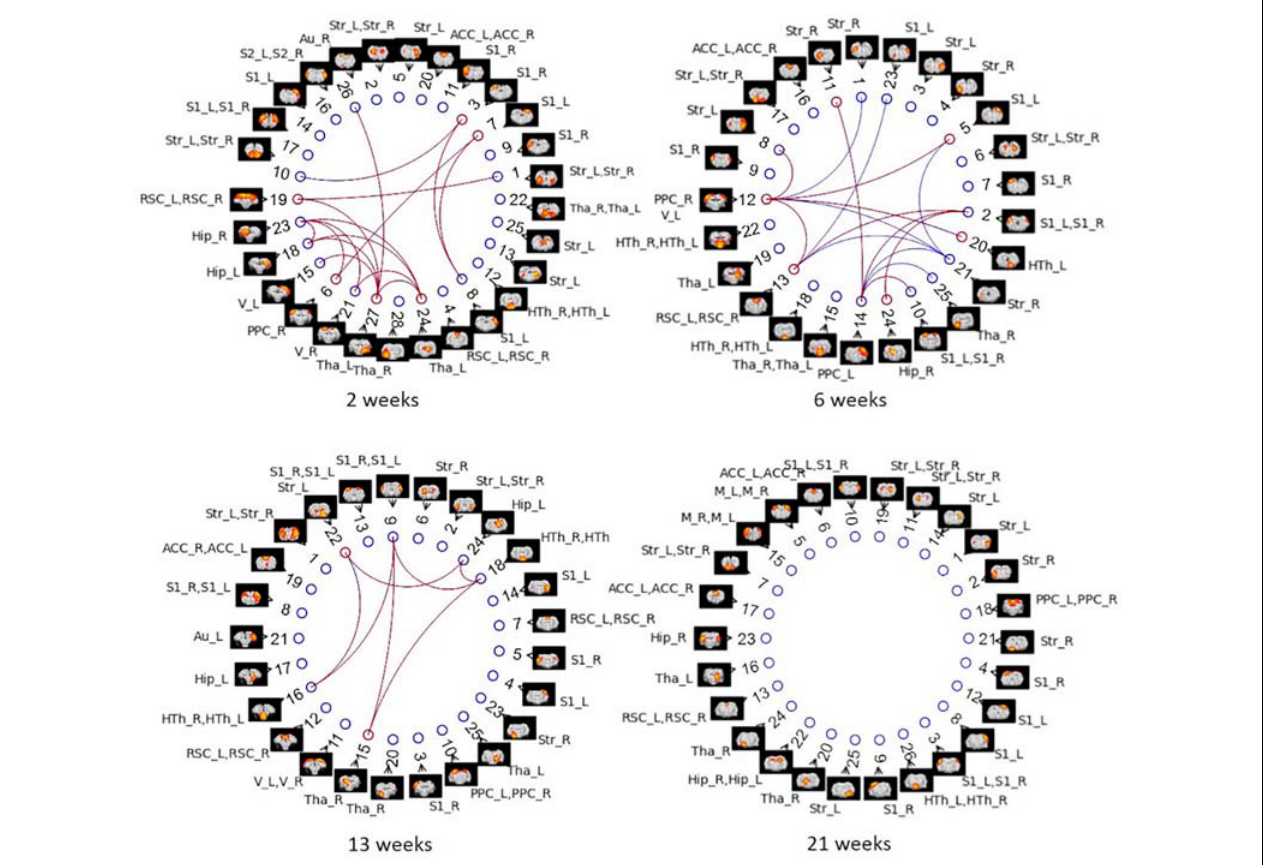
FIGURE 10 | Between-group differences in ICA-based functional connectivity with GSR (partial correlation) at NBS threshold of 2.2 for each timepoint in Cohort 1. Colored edges display the existence of STZ–CTL difference in connections between ICs. Each IC is denoted by a spatial map and its IC number. The nodes of ICs are listed in an order based on its position in the brain (anterior to posterior). ROI labels are attached to every ICA component. Artifactual components were removed, and the IC number was reordered accordingly. Blue edges indicate group differences in contrast 1 ( STZ > CTL ), and red edges indicate group differences in contrast 2 ( STZ < CTL